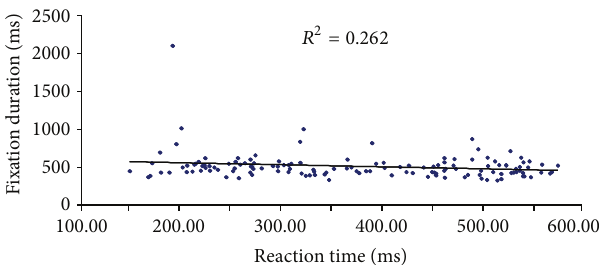
Figure 3: Correlation between gaze parameter and response time in experts’ correct responses. Dots represent all participants’ mean value for each correct trial. The line represents the regression coefficient ( 𝑟 = −.22 , 𝑃 < .001 ) for expert